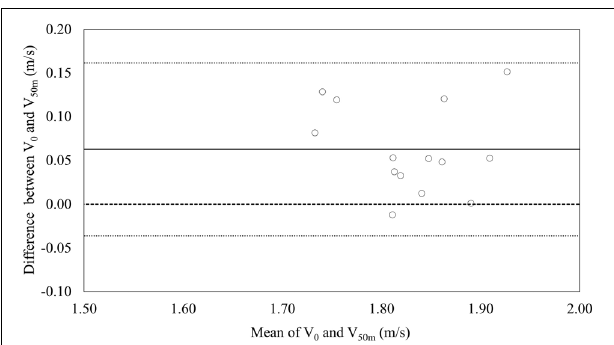
FIGURE 5 | Bland-Altman plot showing the absolute agreement between maximum velocities estimated by the load-velocity profile and obtained from the race